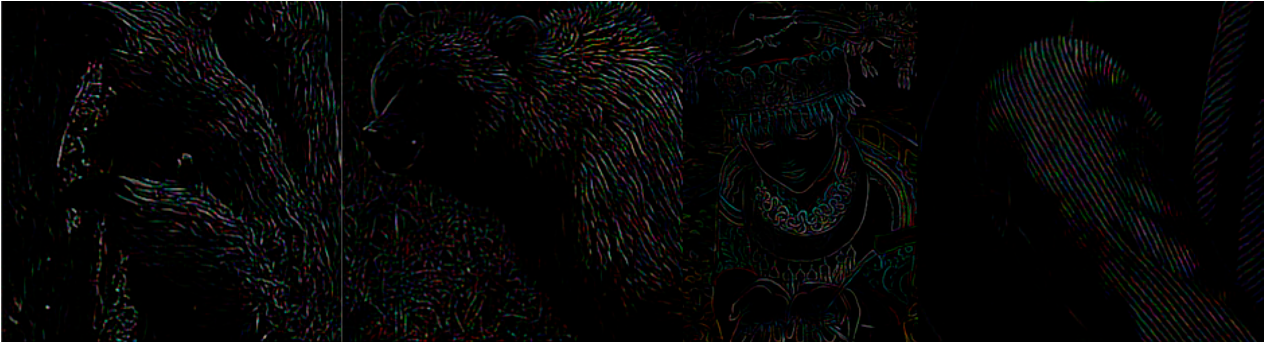
Figure 8. Experimental results for BSDS100.